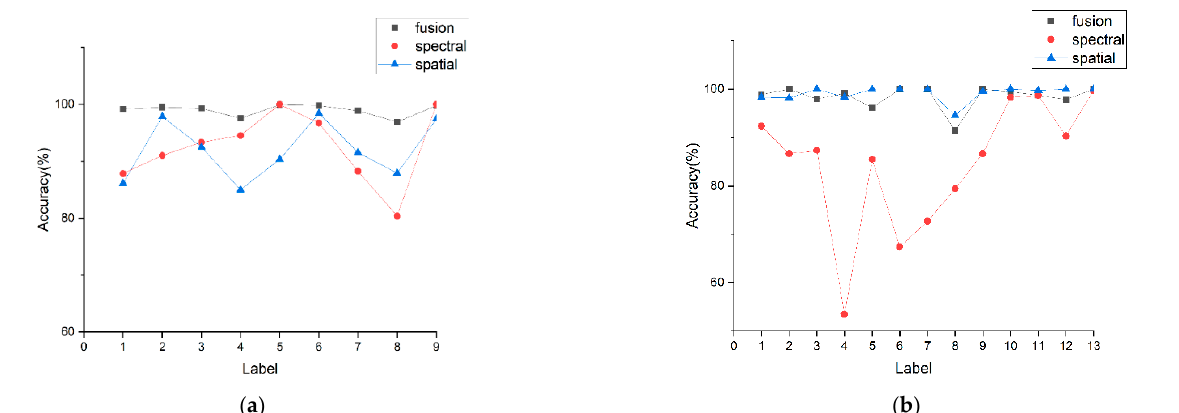
Figure 4. Classification accuracy versus label with fusion feature, spectral feature, and spatial feature for the ( a ) Pavia University dataset and ( b ) Kennedy Space Center dataset.